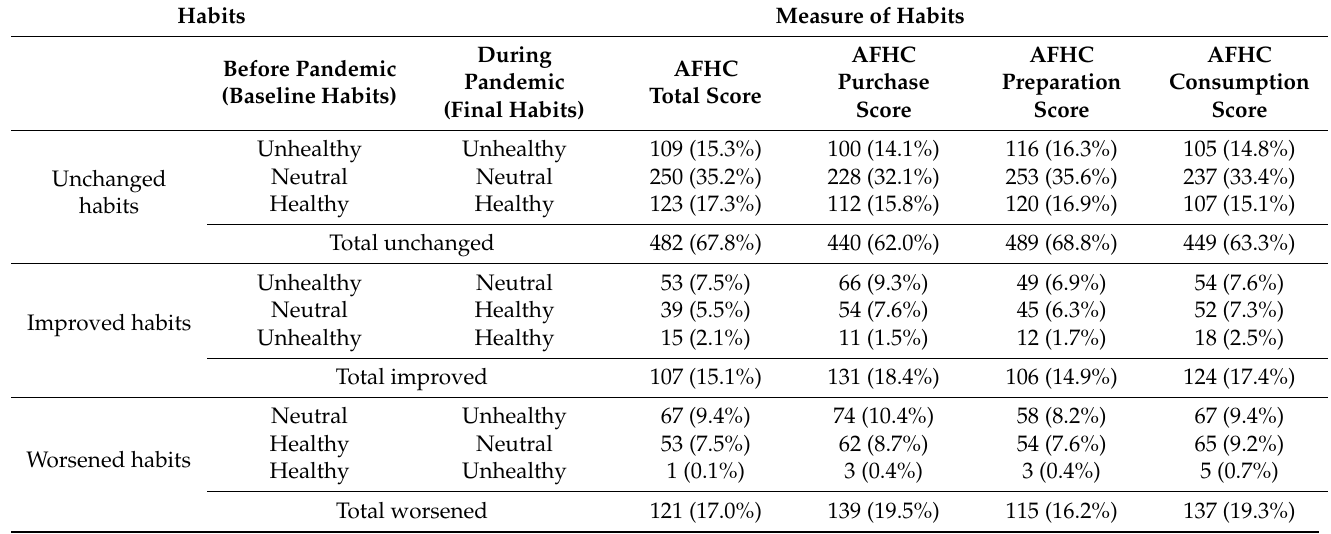
Table 7. The changes in Adolescents’ Food Habits Checklist (AFHC) scores during the COVID-19 pandemic, in categories of healthy, neutral, and unhealthy habits, for the population of female adolescents from the Diet and Activity of Youth during COVID-19 (DAY-19) Study ( n = 710). Measure of